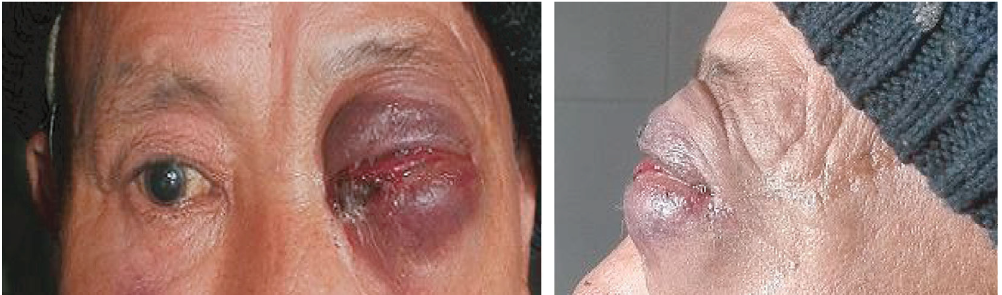
Figure 1: Orbital cellulitis at presentation in the left eye (front and lateral